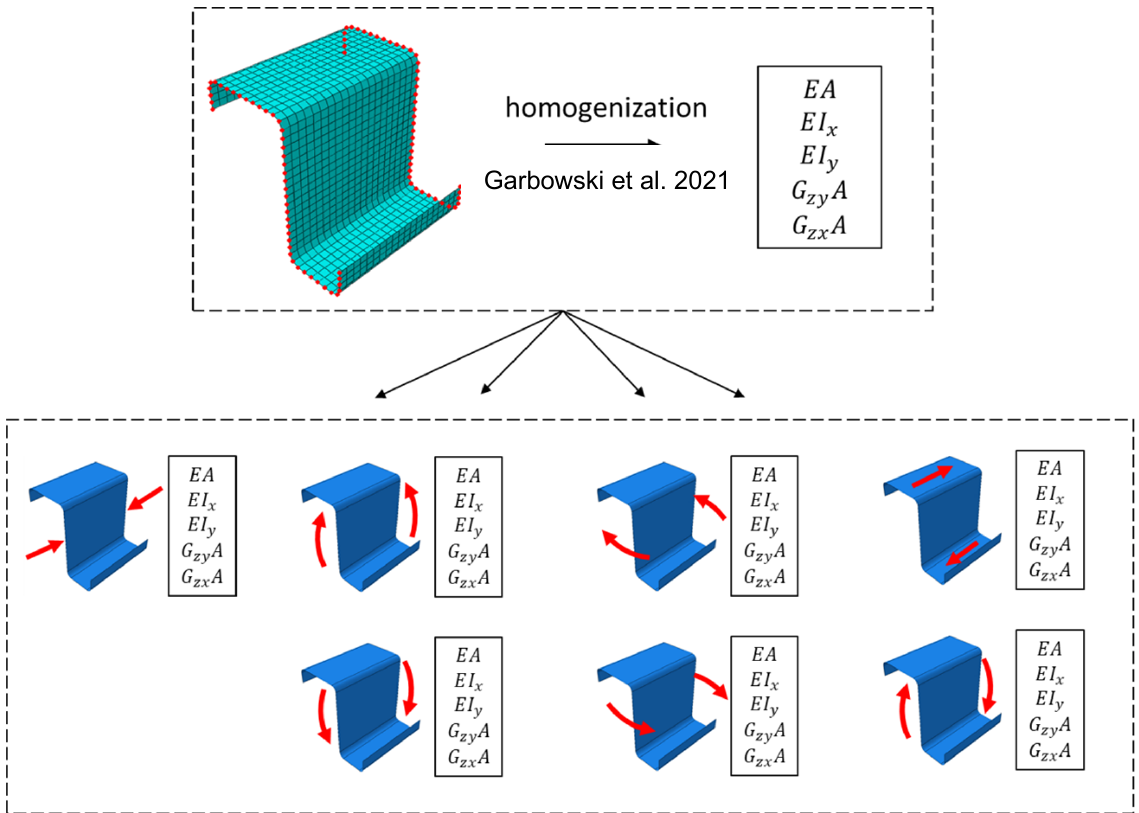
Figure 1. Schematic illustration of the study workflow: shell-to-beam homogenization (Garbowski et al. 2021 [18]) for the reference beam and its counterparts for beams with imperfections due to different